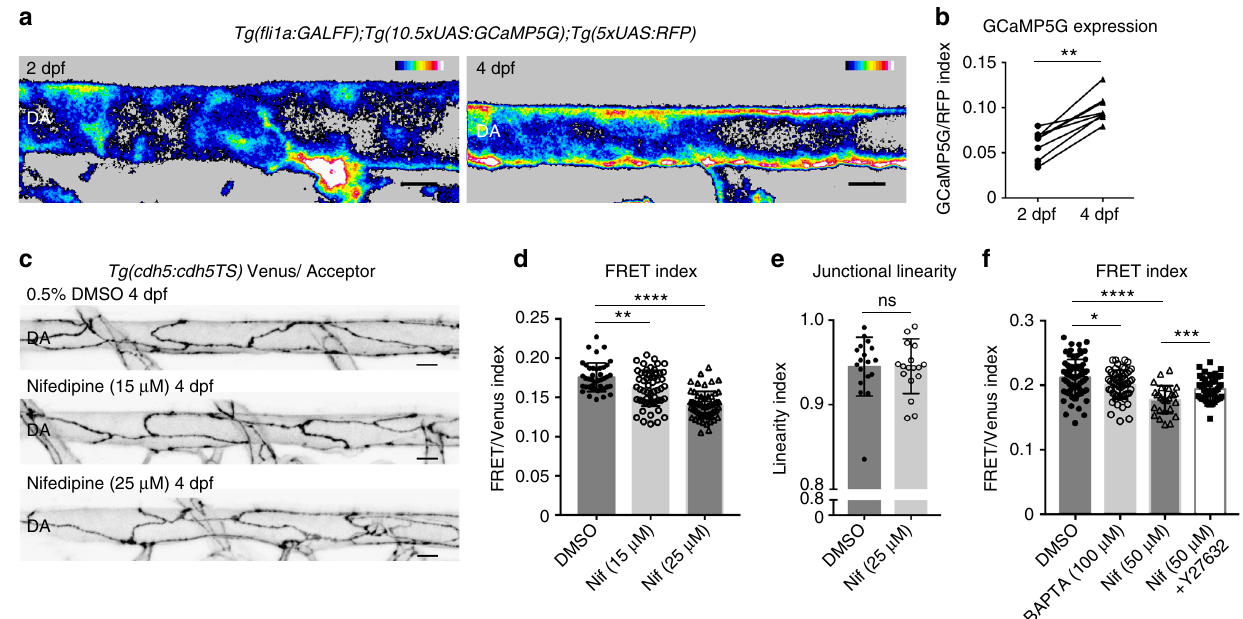
Fig. 5 Calcium signaling maintains lower VE-cadherin tension during artery maturation. a Heatmap image showing average intensity projection of fl i1a - driven GCaMP5G expression (indicating calcium) in the DA at 2 dpf (left) and 4 dpf (right). Colors range from black ( = low calcium) to white ( = high calcium). Scale bar = 10 μ m. b Increase in fl uorescence intensity index ( = fl i1a driven GCaMP5G/ fl i1a -driven RFP) in the dorsal wall of the DA of n = 9 embryos imaged at 2 and 4 dpf. ** p = 0.0012, from paired t test. c Junctional morphology of ECs in the DA (Venus, grey) of a 0.5% DMSO, a 15 μ M/0.5% DMSO Nifedipine and a 25 μ M/0.5% DMSO Nifedipine treated embryo at 4 dpf. Treatment from 2 to 4 dpf. Scale bar = 10 μ m. d Ratio-metric FRET values in junctions of 0.5% DMSO ( n = 42 junctional ROIs from n = 5 embryos), 15 μ M Nifedipine ( n = 54 junctional ROIs from n = 6 embryos) and 25 μ M Nifedipine ( n = 59 junctional ROIs from n = 6 embryos) treated embryos. Treatment was from 2 to 4 dpf. Error bars represent mean ± s.d.; DMSO – 15 μ M Nifedipine ** p = 0.0068, DMSO – 25 μ M Nifedipine **** p < 0.0001, from unpaired two-sided Mann – Whitney test. e Junctional linearity index in 0.5% DMSO treated controls ( n = 5) versus 25 μ M Nifedipine-treated embryos ( n = 6). Each data point represents a junction, n = 18 control junctions measured and n = 18 junctions from Nifedipine-treated embryos. Error bars represent mean ± s.d.; not signi fi cant (ns) p = 0.8147, from unpaired two-sided Mann – Whitney test. f Ratio-metric FRET values quanti fi ed from 1% DMSO-treated controls ( n = 39 junctional ROIs from n = 6 embryos), BAPTA-AM- treated (100 μ M for 1 h, n = 58 junctional ROIs from n = 8 embryos), Nifedipine-treated (50 μ M for 30 min, n = 27 junctional ROIs from n = 5 embryos) and Nifedipine + Y-27632-treated embryos ( n = 47 junctional ROIs from n = 8 embryos). Error bars represent mean ± s.d.; 1% DMSO – 100 μ M BAPTA-AM * p